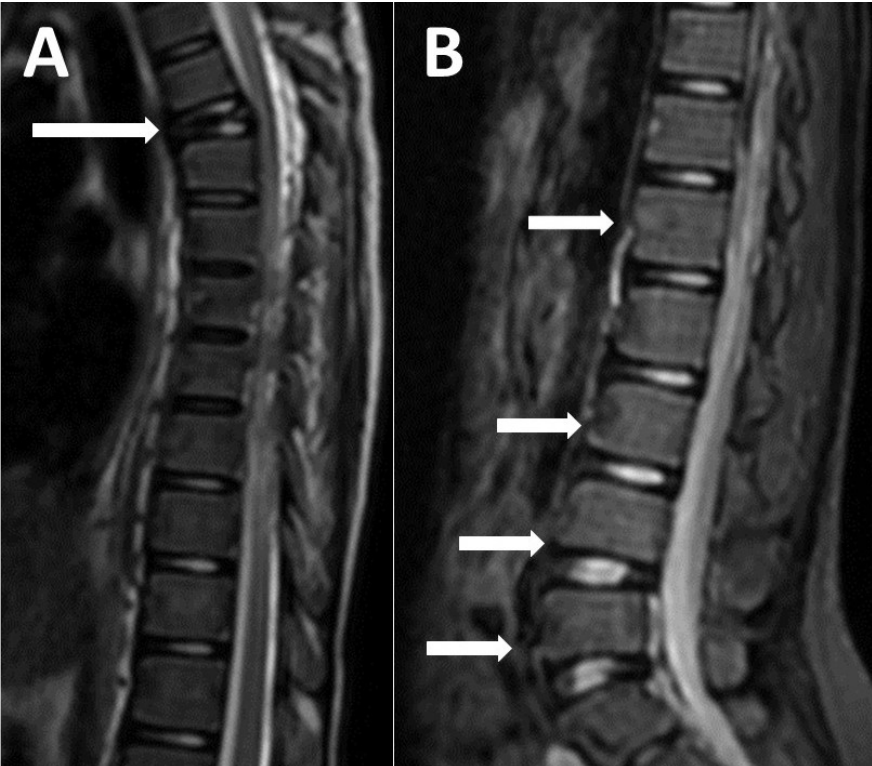
Figure 5. Spine. A - Pathological fracture at T3 vertebra, sagittal STIR image of the cervical spine. B - Subtle signal reduction showed in the vertebrae and Modic type 1 changes, sagittal STIR image of the lumbar